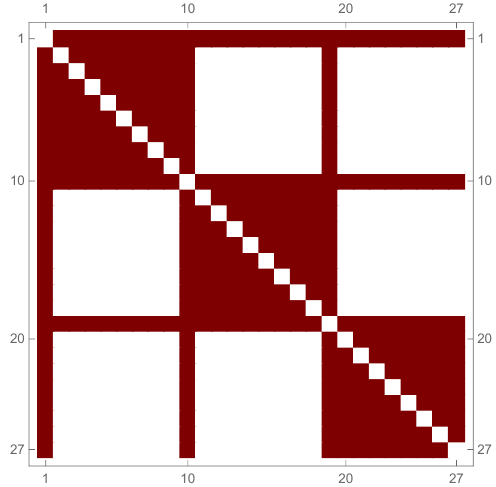
Figure 6 . Structure of the matrix of Mandelstam invariants s ij on the split kinematic subspace. For illustration purposes a sufficiently generic case is presented. Here n = 27 split kinematics (1 , 10 , 19) is shown, having set to zero all s ab ’s in the unshaded